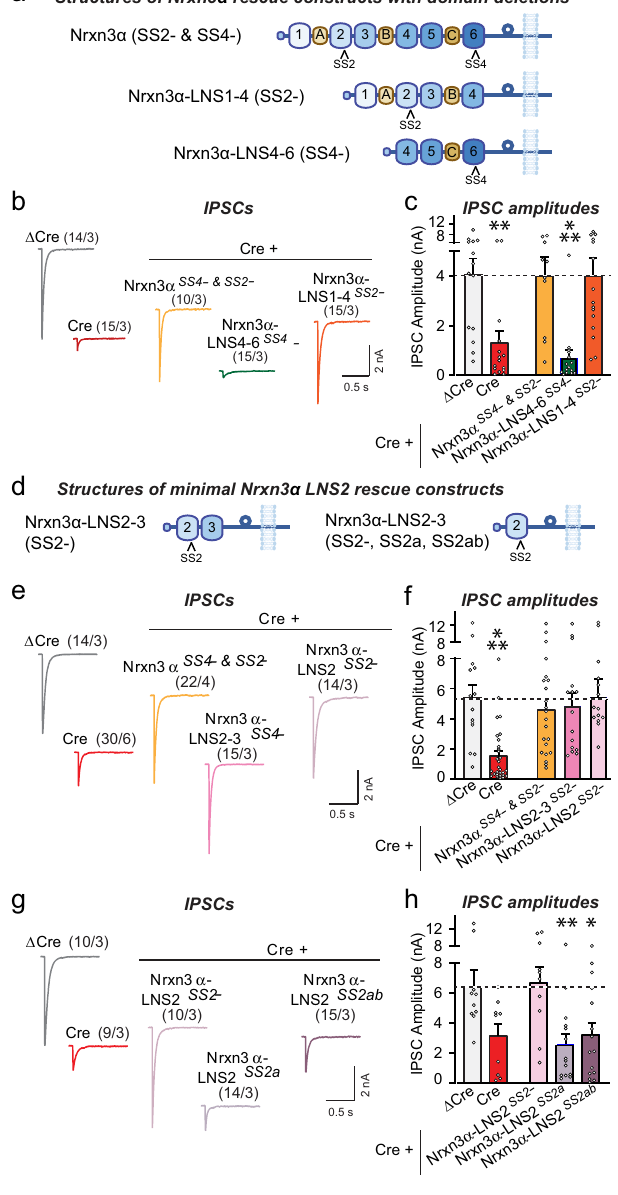
Fig. 2 | A minimal protein composed of the single LNS2-domain of Nrxn3 α attached to its C-terminal stalk sequence, transmembrane region and cyto- plasmic sequence fully rescues inhibitory synaptic transmission in cultured Nrxn3-de fi cient OB neurons. All experiments were performed in dissociated OB cultures obtained from newborn Nrxn3 cKO mice that were infected with lenti- viruses expressing Δ Cre (control) or Cre without or with the indicated rescue proteins. a Schematic of Nrxn3 α rescue constructs with domain deletions. b , c Nrxn3 α lacking LNS5 and LNS6 domains fully rescues impaired inhibitory synaptic transmission in Nrxn3 -de fi cient OB neurons, whereas Nrxn3 α lacking LNS1-3domainsdoesnot(b,sampletraces;c,summarygraphsofIPSCamplitudes). d Schematic of minimal Nrxn3 α rescue constructs. e , f A minimal Nrxn3 α protein containing only LNS2 without an SS2 insert linked to the C-terminal Nrxn3 α sequences,rescuesimpairedinhibitorysynaptictransmissionin Nrxn3 -de fi cientOB neurons( e ,sampletraces; f ,summarygraphsofIPSCamplitudes). g , h Theminimal Nrxn3 α protein containing only LNS2 is unable to rescue inhibitory synaptic transmission in Nrxn3 -de fi cient OB neurons if SS2 contains an insert (g, sample traces; h, summary graphs of IPSC amplitudes). Numerical data are means±SEM; n ’ s (cells/experiments) are indicated above the sample traces and apply to